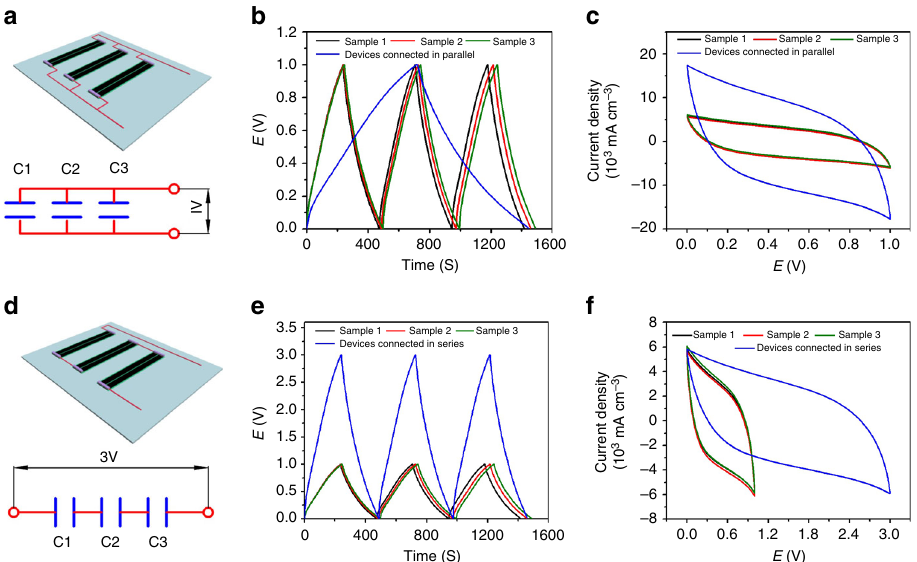
Fig. 5 Assembly and electrochemical performance of multiple SC tapes. a – c Schematic and equivalent circuit ( a ), galvanostatic charge/discharge curves ( b ), and CV curves ( c ) of the three tape SCs connected in parallel. d – f Schematic and equivalent circuit ( d ), galvanostatic charge/discharge curves ( e ), and CV curves ( f ) of the three tape SCs connected in series. The galvanostatic charge/discharge curves and CV curves of the three corresponding individual tape SCs used to assemble multiple SCs were also